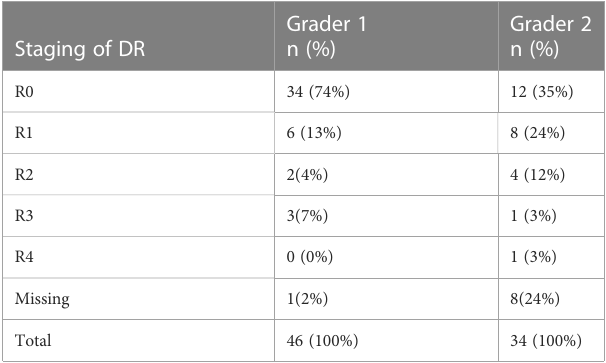
TABLE 6 DR staging of the ungradable 3 rd grader images by 1 st and 2 nd graders.